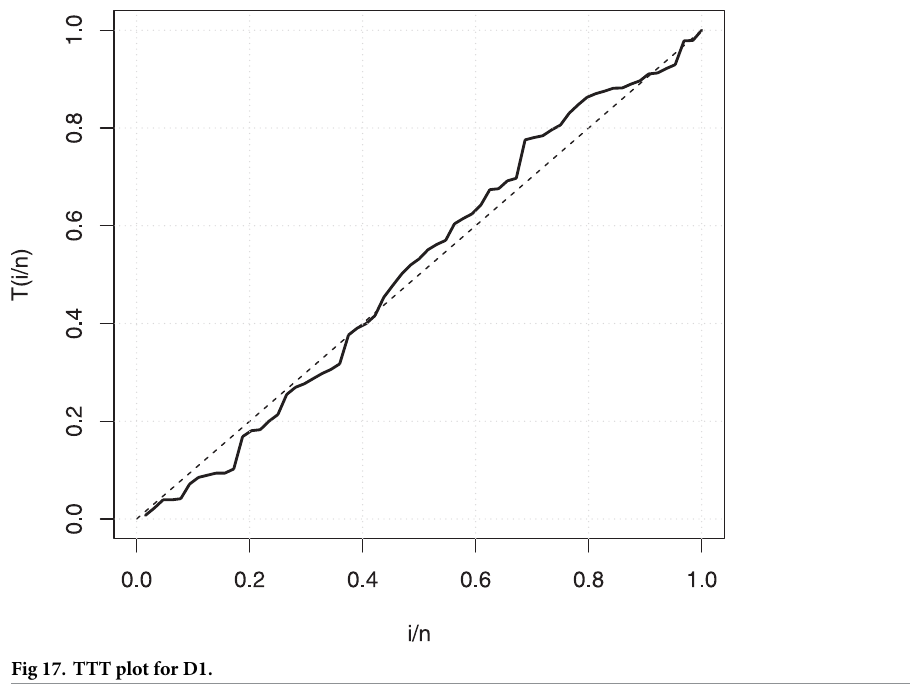
Fig 17. TTT plot for